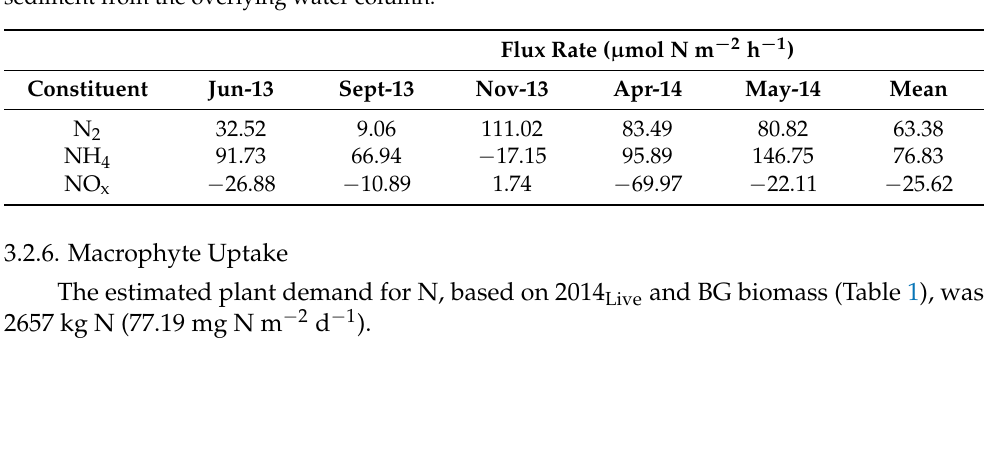
Table 6. Summary mean annual net sediment inorganic N fluxes for the Cell 1B marsh. Fluxes were adjusted for day length and marsh platform and creek areas. Negative values represent flux into the sediment from the overlying water